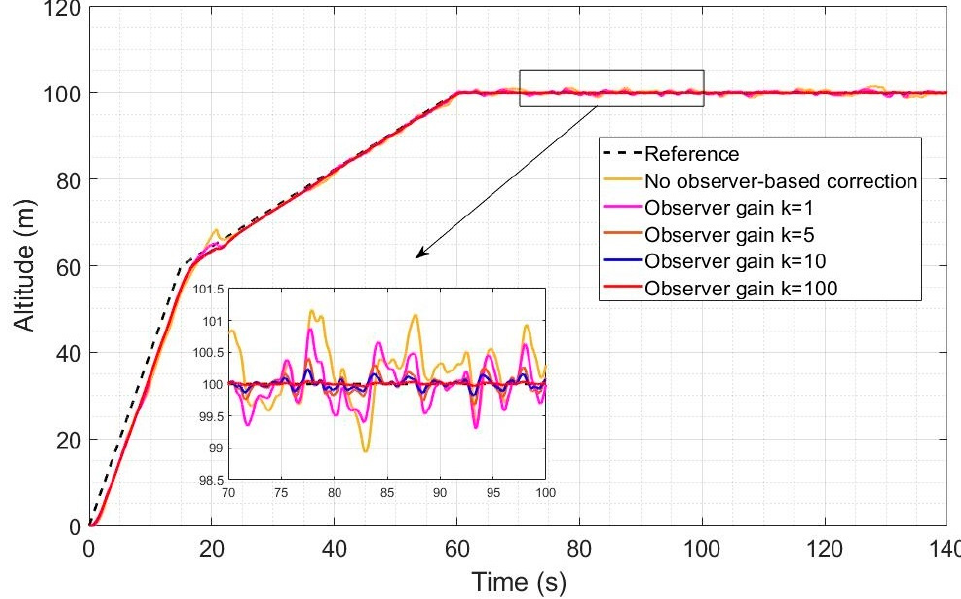
Figure 8. Altitude reference tracking under a low wind intensity for different values of the pertur- bation observer gain.